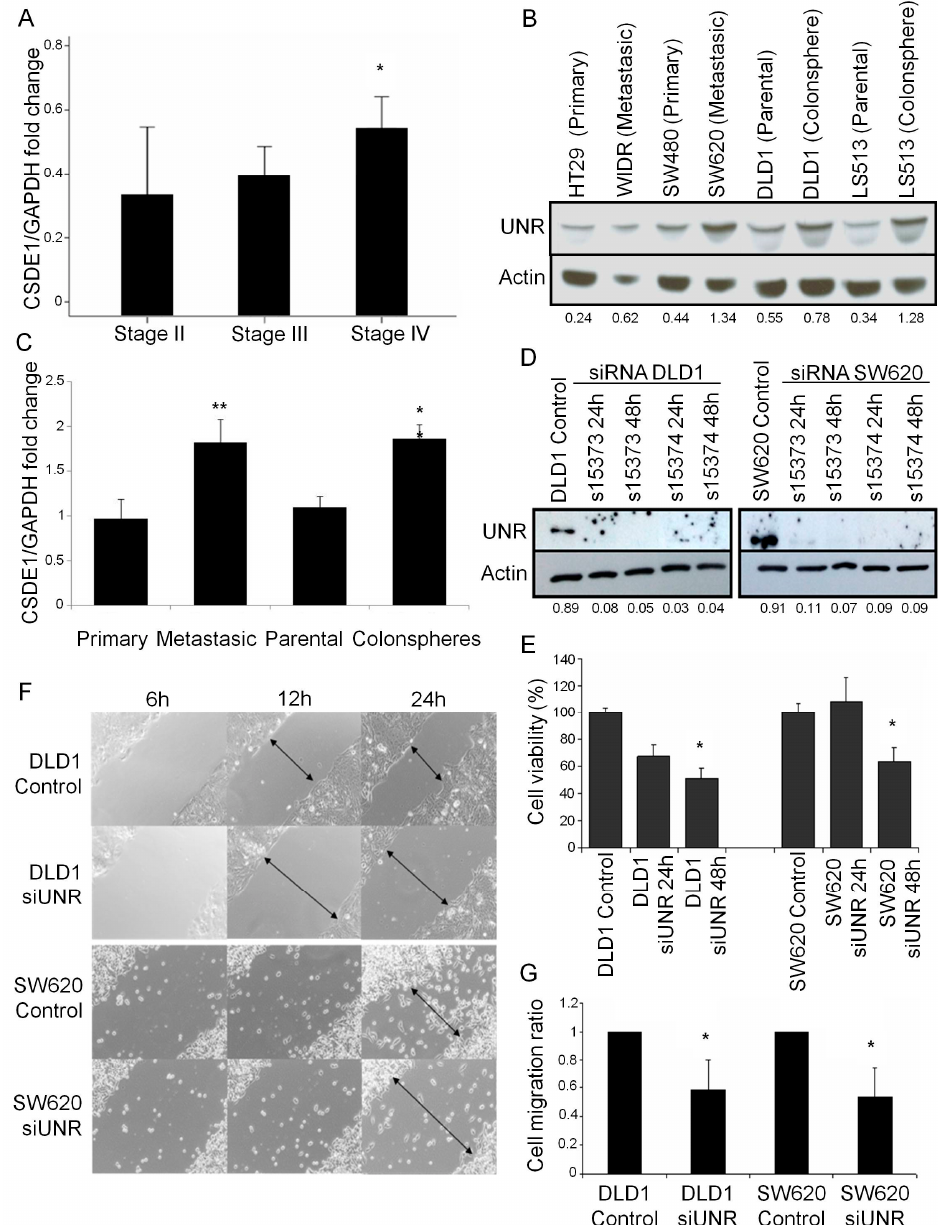
Figure 2. UNR / CSDE1 promotes metastatic phenotype in CRC. ( A ) CSDE1 mRNA expression of eight stage II tumor samples, 16 stage III tumor samples, and six stage IV tumor samples by qRT-PCR. ( B ) UNR protein expression of primary and metastatic CRC cell lines and parental and colospheres derived CRC cell lines. ( C ) CSDE1 mRNA expression of CRC derived cell lines from ( B ) grouped by origin. ( D ) Two di ff erent siRNAs of csde1 (si15373 and si15374) were used to downregulate UNR protein expression in DLD1 and SW620 CRC derived cell lines. We verified UNR expression levels by western blot at 24 and 48 h after transfection. ( E ) MTS assay showed that both DLD1 and SW620 cell lines decreased cell viability at 48 h after UNR downregulation. ( F ) Microscope images of wound healing assay showed a reduced cell migration after UNR downregulation in both cell lines. Representative images taken at 6, 12, and 24 h after scratching. Arrows represent distance between cell migration heads. ( G ) Cell invasion assays performed in Boyden chamber showed that UNR silencing decreased invasion ability of both cell lines. UNR / Actin ratio is represented under Actin protein bands. All assays were performed with two di ff erent siRNA sequences. (* p < 0.05; ** p <